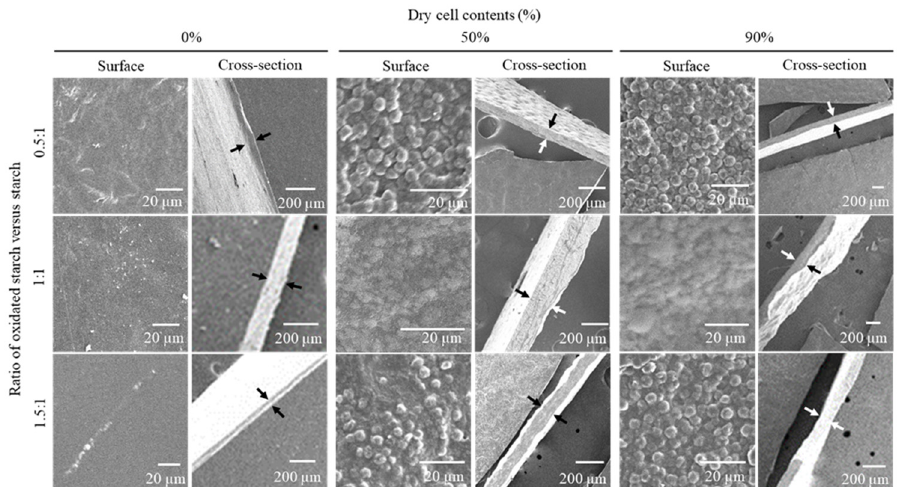
Figure 2. SEM images of surfaces and cross-sections of starch cell-plastics and starches, respectively. The white and black arrows show the thickness of those cross-sections. The white lines are inserted as scale bars.